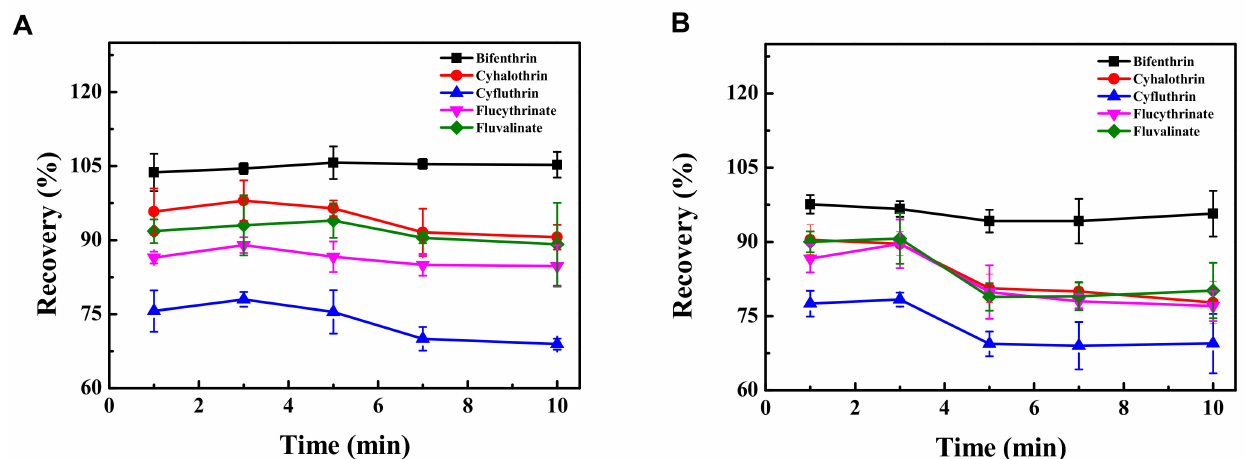
Figure 4. The recovery rate changes with the standing time after the acetonitrile phase was separated from the water phase for a simple substrate ( A ) and a complex substrate ( B